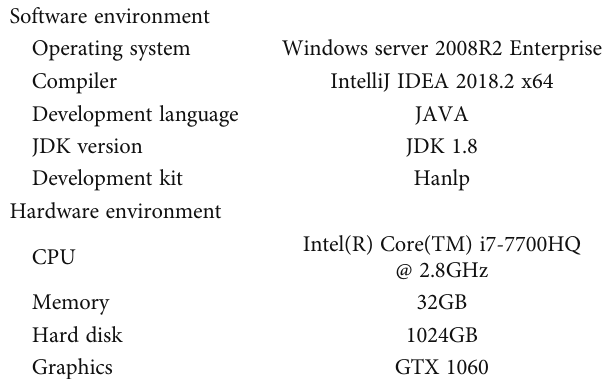
Algorithm 3: Steps of teacher portrait construction. Table 6: Con fi guration table of the experimental